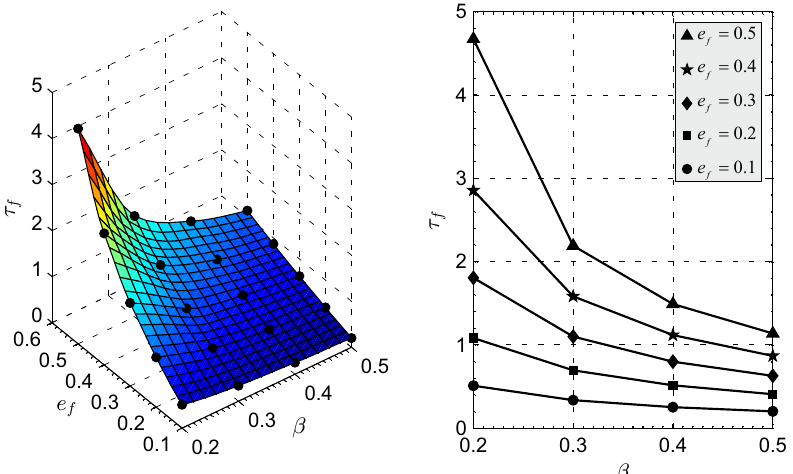
Figure 2. Minimum flight time τ f as a function of e f and β .